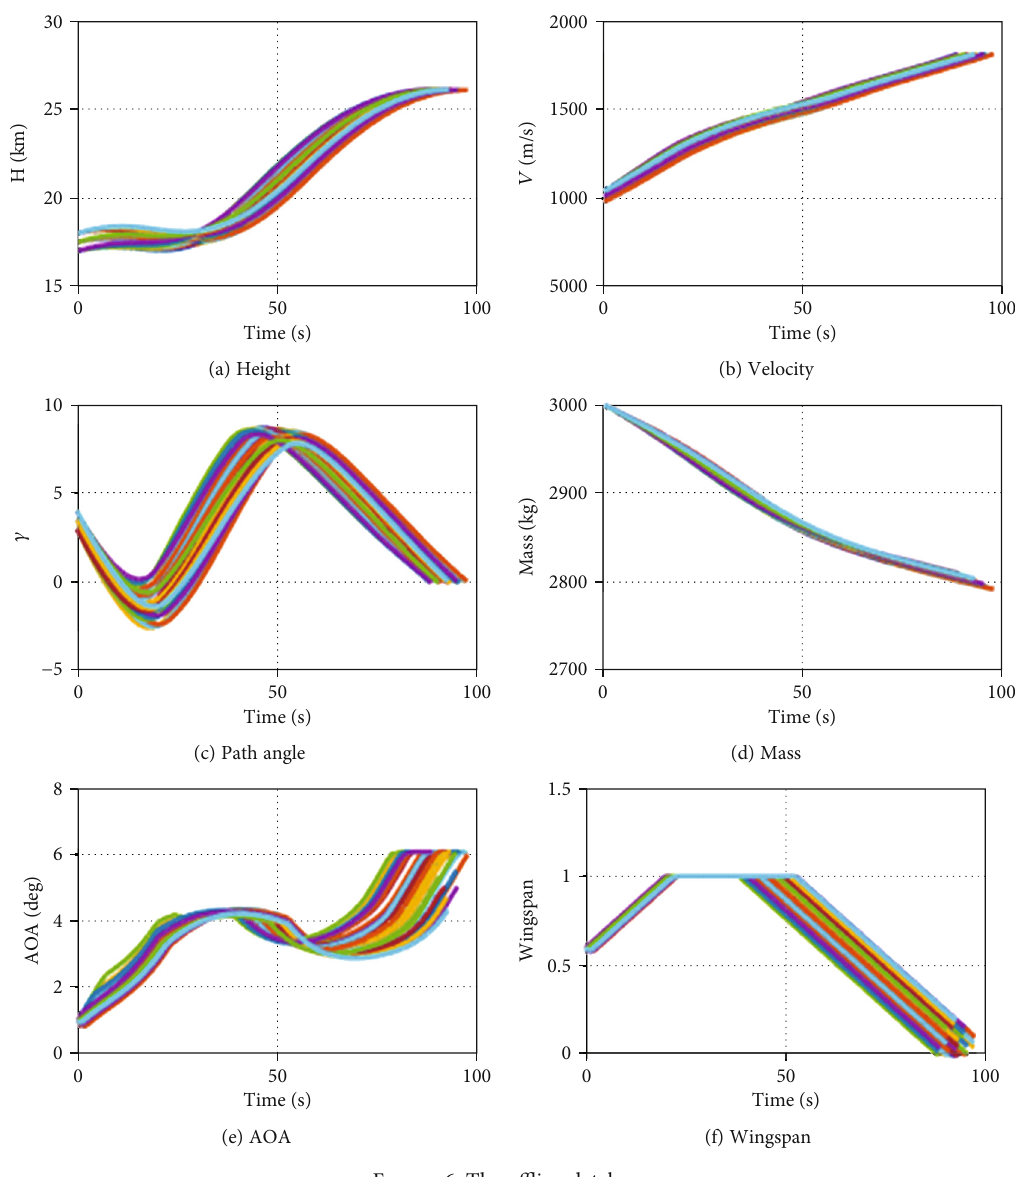
Figure 6: The o ffl ine